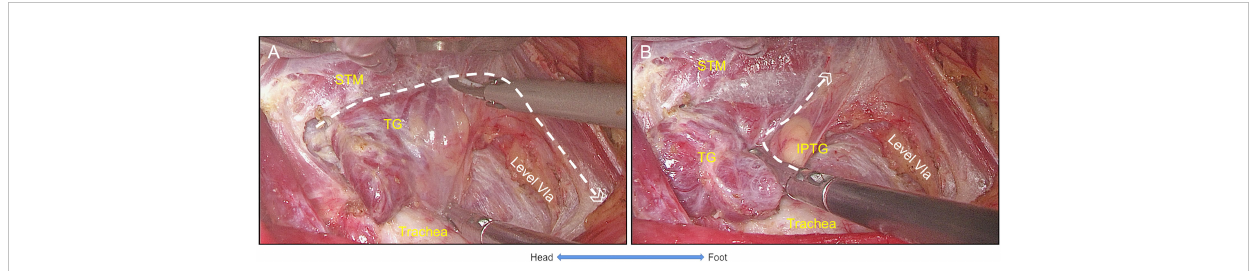
FIGURE 5 The settlement of trachea. (A) The thyroid gland was freed from sternothyroid muscle and trachea respectively. (B) Inferior parathyroid gland was identi fi ed and preserved with its vessel branches from the thymus. Thus, the settlement of trachea was completed with the en bloc resection of the thyroid gland and Level VIa. STM, sternothyroid muscle; TG, thyroid gland; IPTG, inferior parathyroid